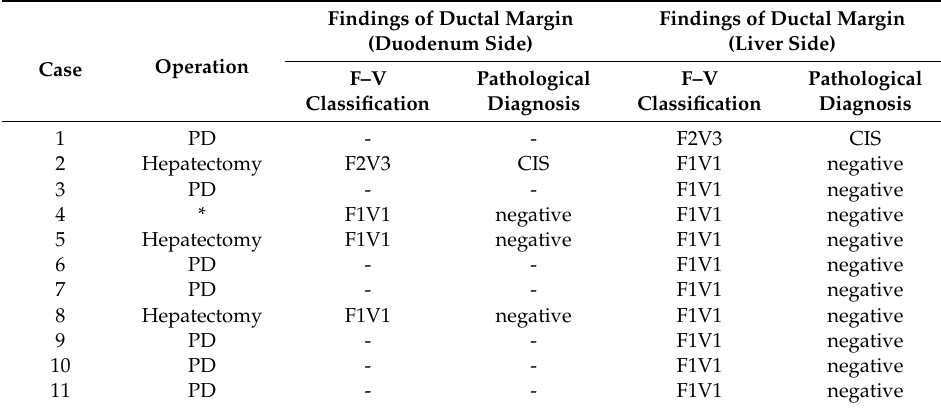
Table 2. Relationship between F–V classification and pathology diagnosis of resected